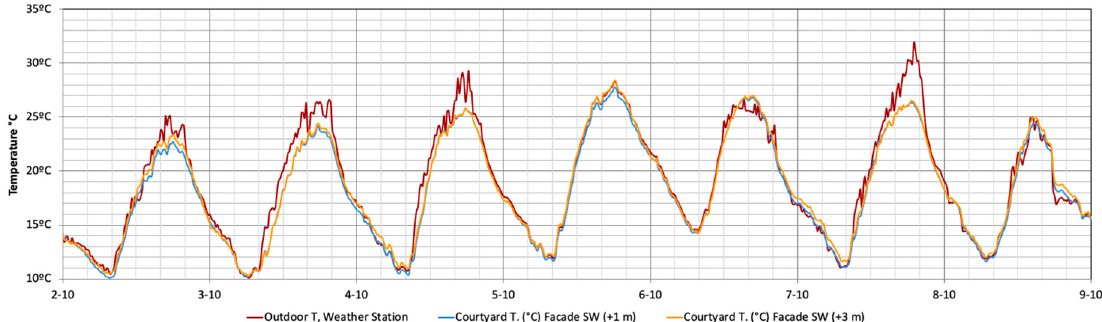
Figure 12. Previous thermal behavior (12–19 October) of case study 1.